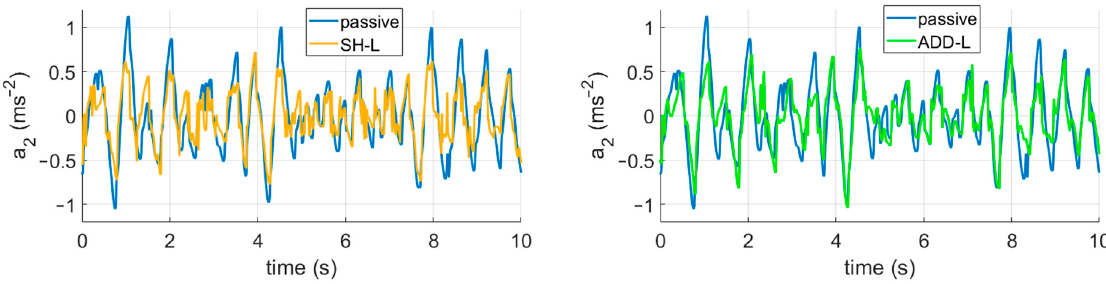
Figure 11. Courses of lateral body acceleration in the time domain for passive mode, SH-L control ( left ) and ADD-L control ( right ), HILS results.